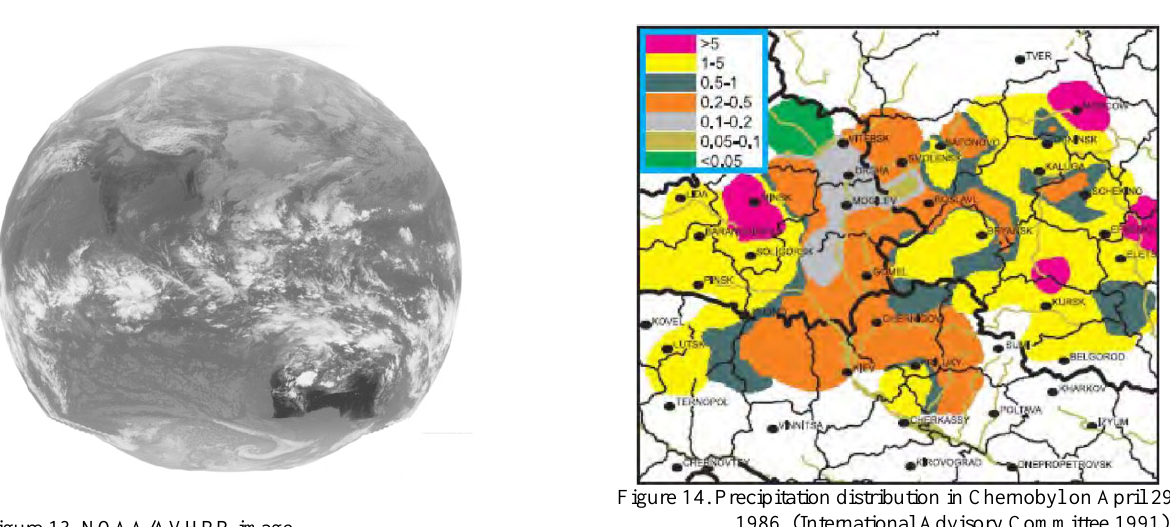
Figure 13. NOAA/AVHRR image